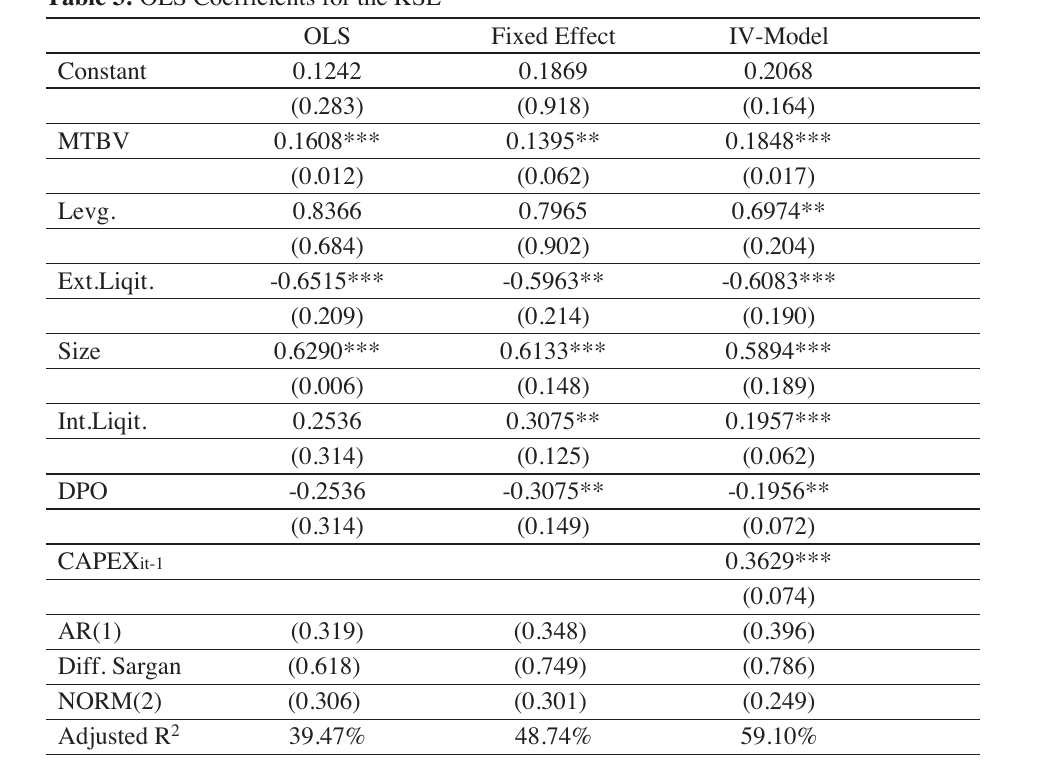
Table 3: OLS Coefficients for the